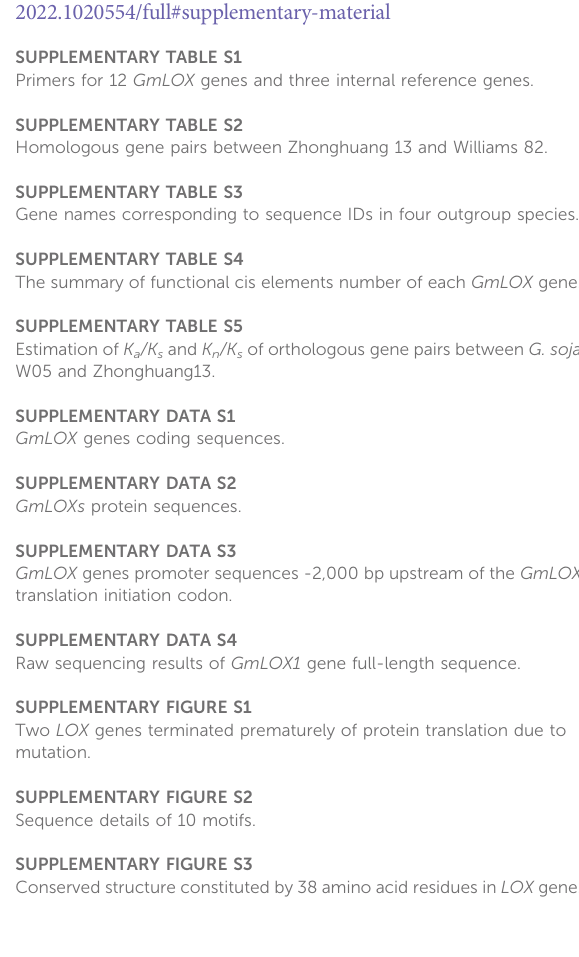
SUPPLEMENTARY FIGURE S2 Sequence details of 10 motifs. SUPPLEMENTARY FIGURE S3 Conserved structure constituted by 38 amino acid residues in LOX